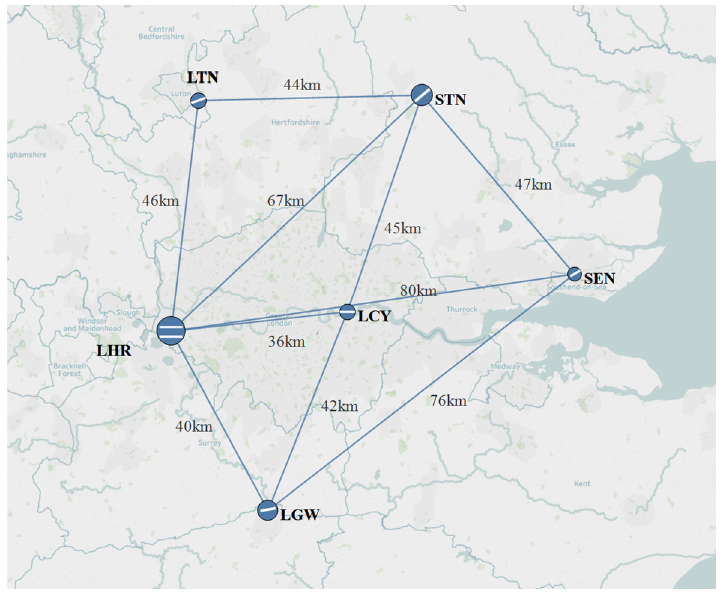
Figure 4. The London MAR.